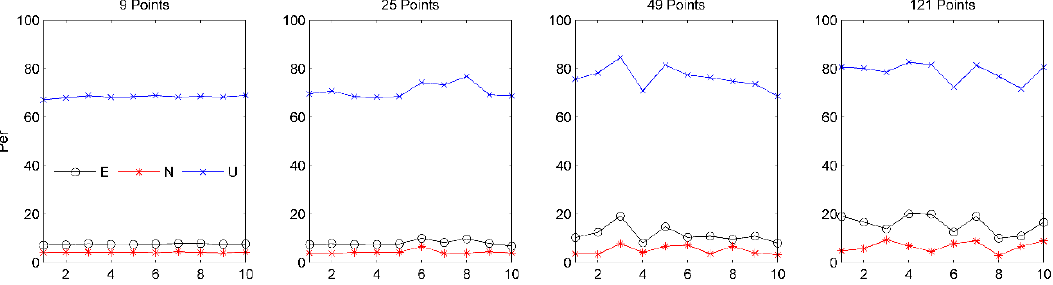
Figure 5. The variation of improvement percentages for Scheme 2 under different global positioning system (GPS) points.